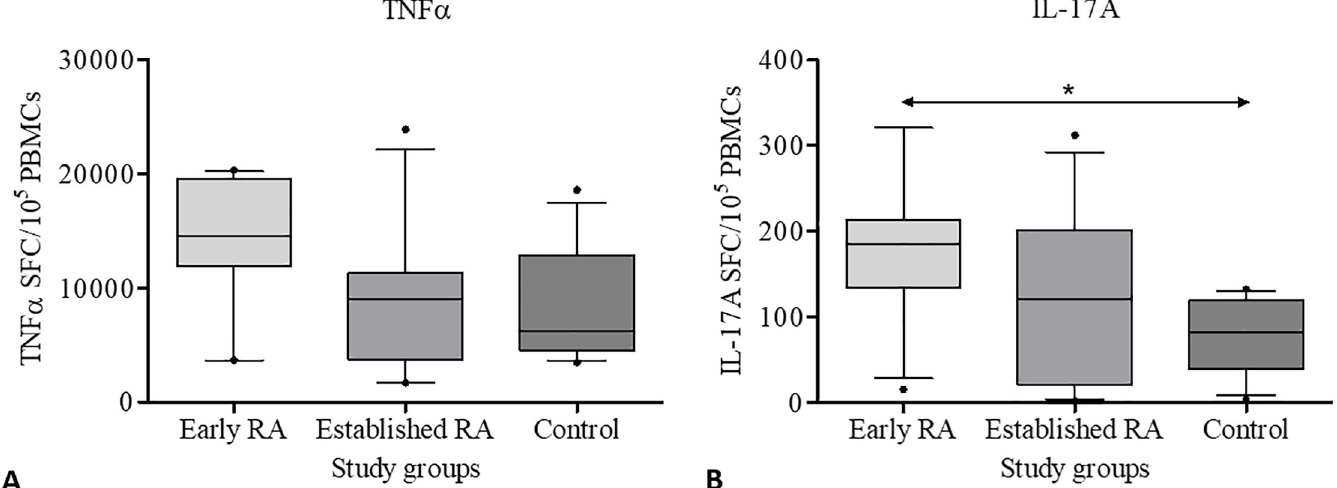
Fig 2. Box and Whiskers plot illustrating the mitogen-stimulated expression of cytokines by PBMCs of early RA patients, established RA patients, and controls. A. TNF- α (p = 0.0282), B. IL-17A (p = 0.0216). Error bars indicate 10–90 percentiles. P < 0.05 was considered statistically significant. SFCs- spot forming cells, PBMC- peripheral blood mononuclear cells. Statistical test–Kruskal-Wallis test. An asterisk indicates the statistically significant difference between the two